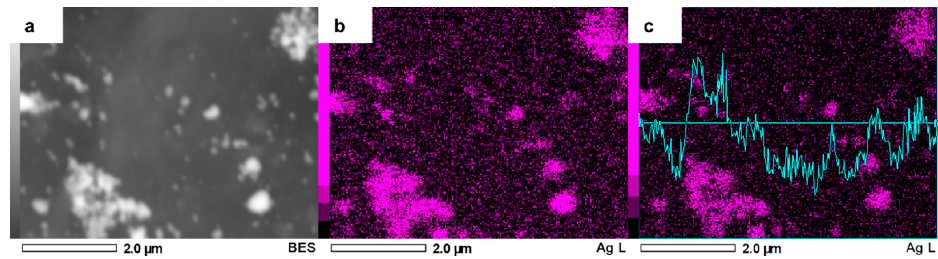
Figure 7. Zoomed-in SEM image of AgCuAlCe bimetallic catalyst ( a ) and the elemental mapping images of ( b ) Ag and ( c ) EDS line scan of Ag.